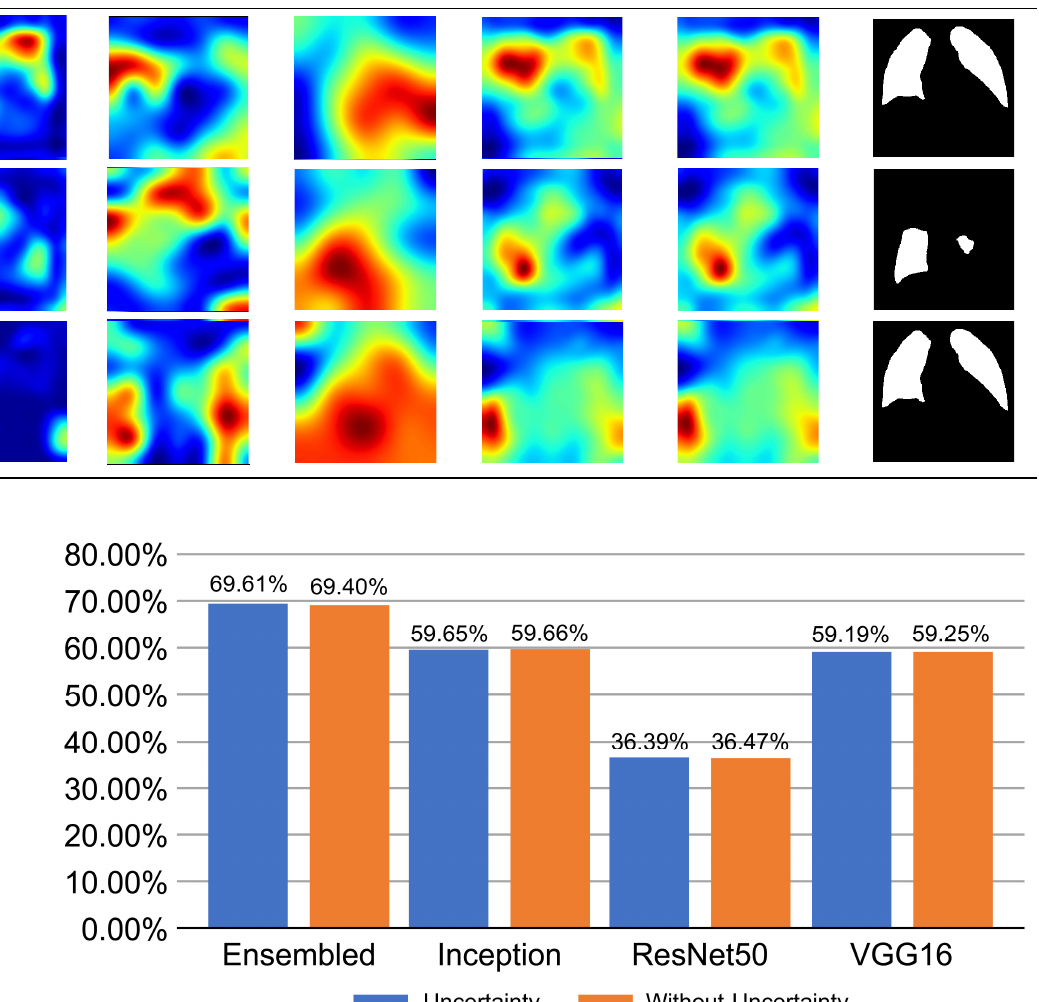
Figure 5. IoU scores with and without uncertainty.